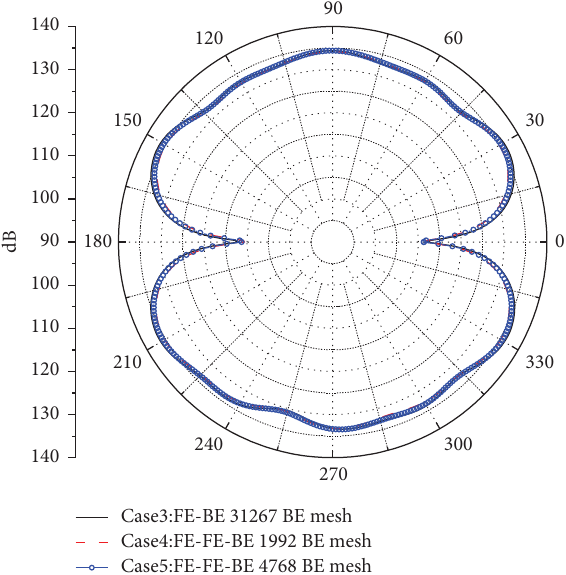
Figure 14: Te comparison results of the FE-FE-BE method and FEM-BEM.